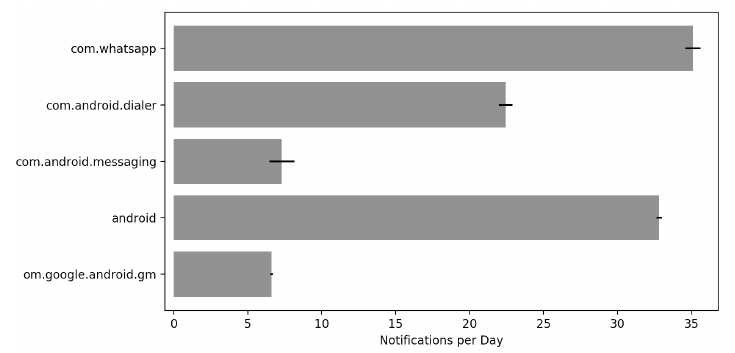
Figure 10. Notifications per application.